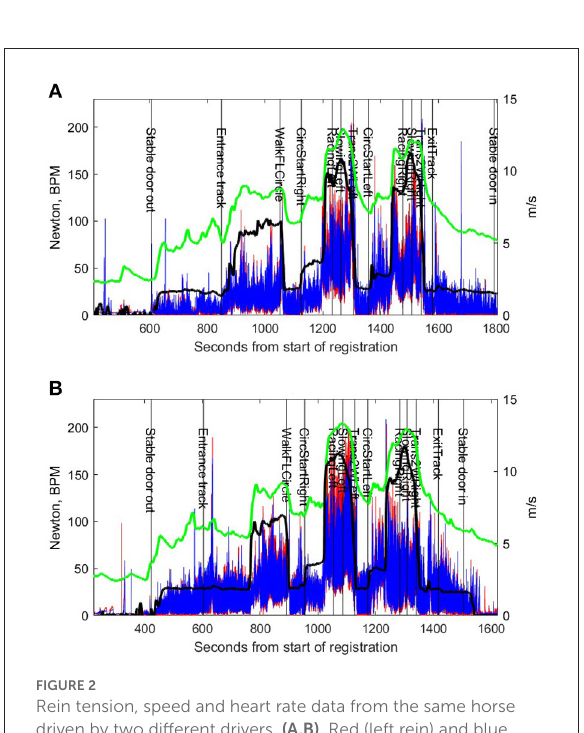
FIGURE2 Rein tension, speed and heart rate data from the same horse driven by two different drivers, (A,B) . Red (left rein) and blue (right rein) traces represent median-filtered rein tension. The black trace represents speed (m/s) and the green trace represents heart rate (beats per minute). The vertical lines and acronyms indicate start of each the exercise test segment (see Table 1) based on the manual time protocols.